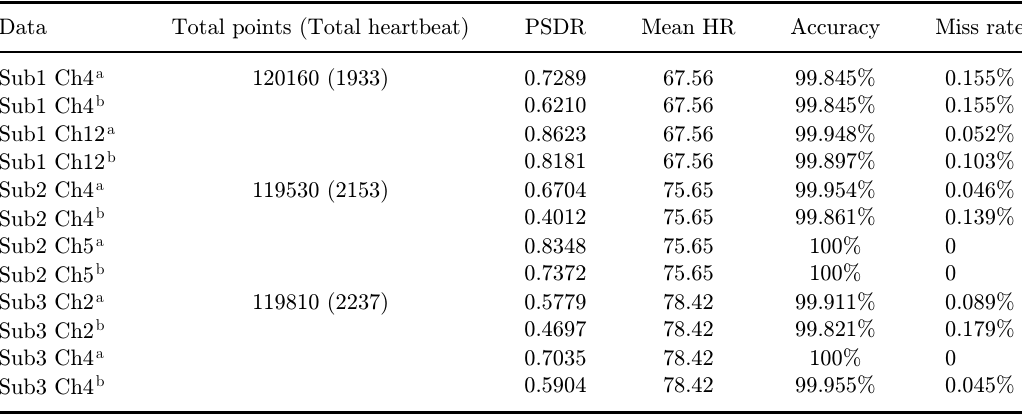
Table 1. The detection results of our method to data with di®erent PSDR when r ¼ 0.5* f s / f heart N min .